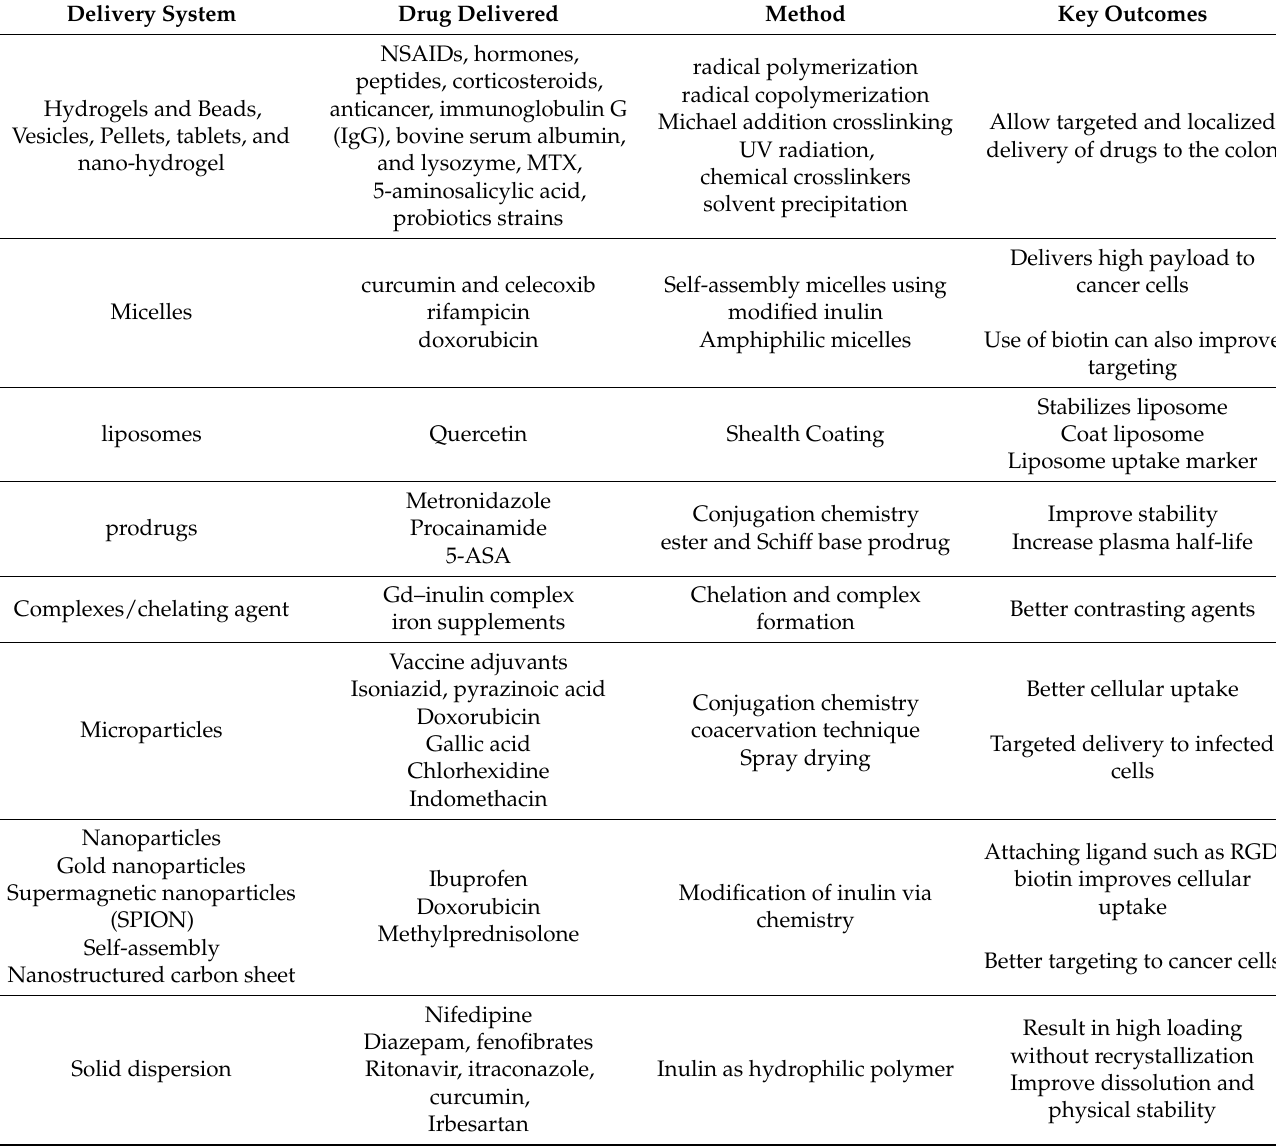
Table 1. Showing a summary of the different delivery systems, drugs delivered, method of fabrication and key outcomes. Delivery